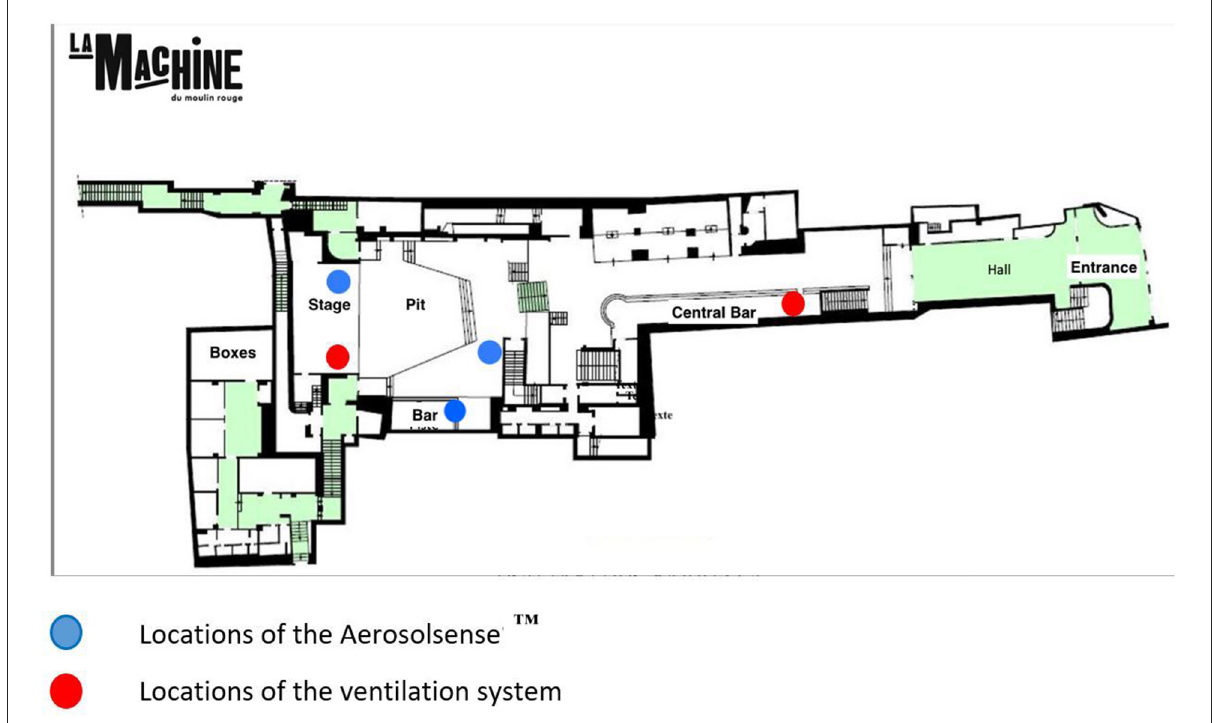
FIGURE1 Plan of the room “La Machine du moulin rouge” and location of the AerosolSense TM and ventilation.